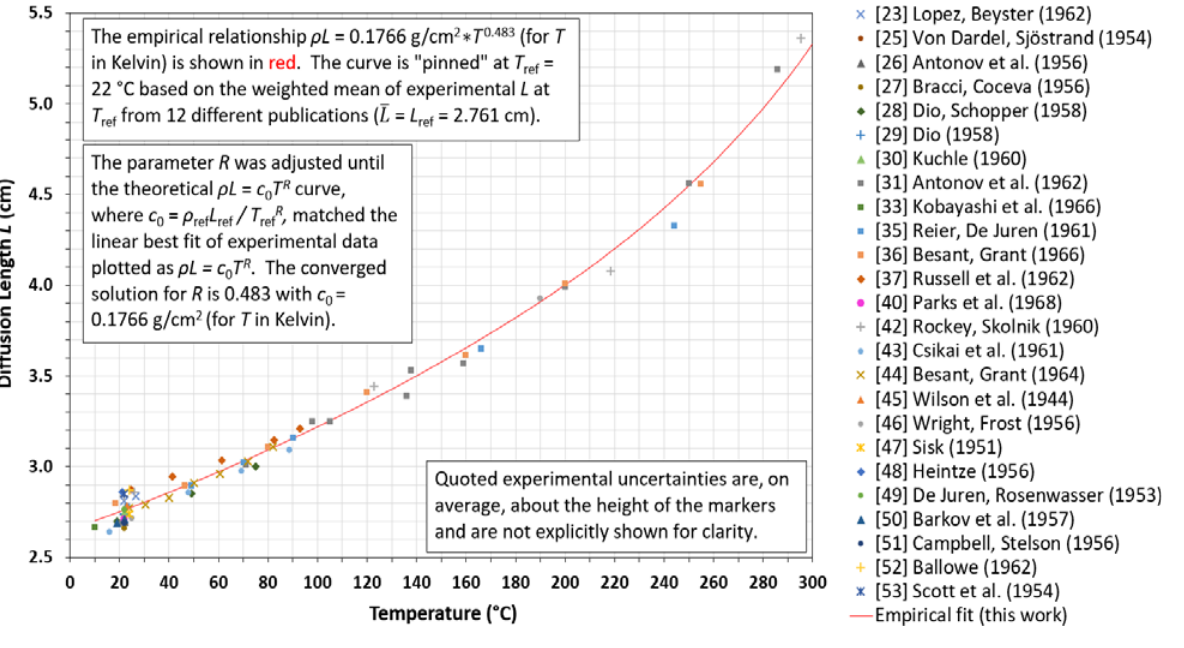
Figure 1. Empirical Fit for L ( T ) Based on 25 Publications at 49 Reported